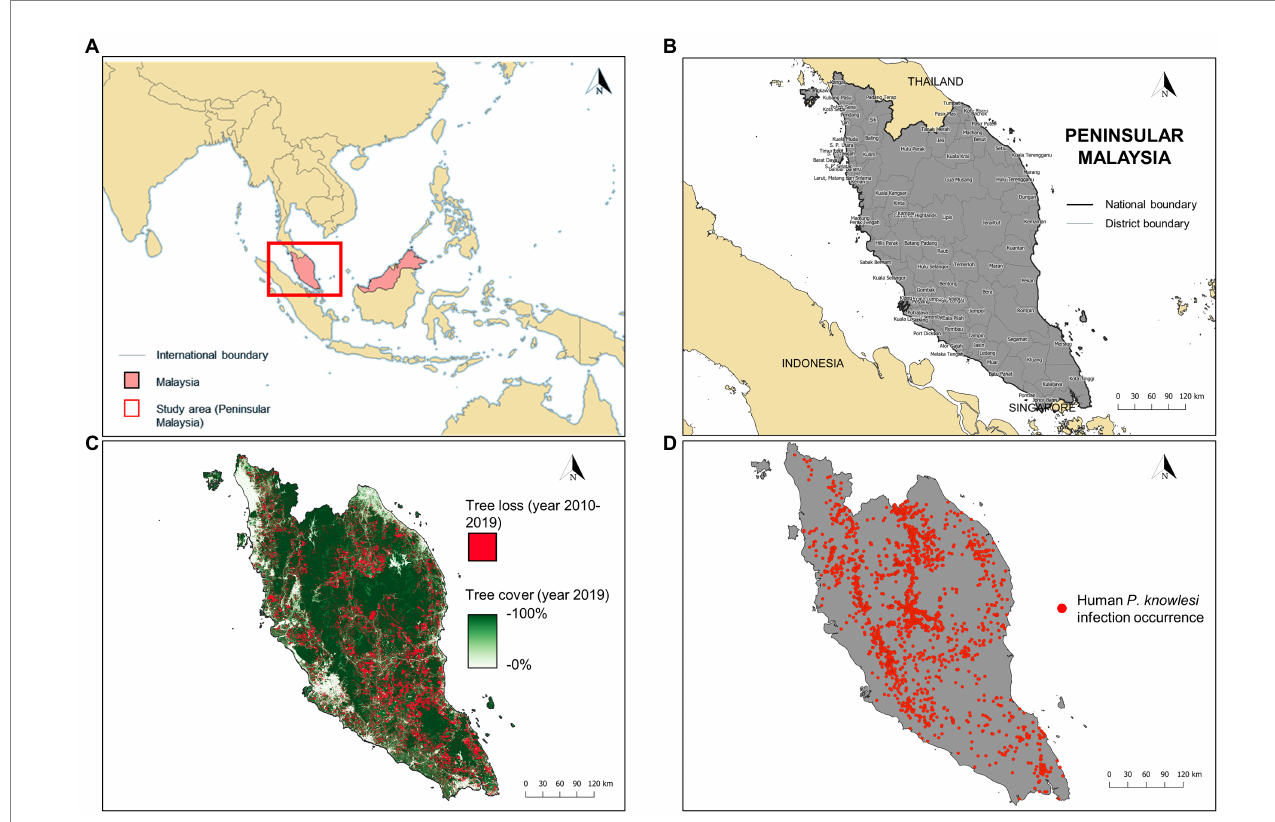
FIGURE 1 (A) Location of Peninsular Malaysia (red box). (B) The district-level administrative boundary of Peninsular Malaysia. (C) Extent of tree loss (recorded in years 2010–2019) and tree cover (recorded in year 2019) in Peninsular Malaysia. Tree loss data was acquired from Global Forest Change database (https:// earthenginepartners.appspot.com/science-2013-global-forest/download_v1.7.html) whereas tree cover data was acquired from Copernicus Global Land Service (https://zenodo.org/record/3939050#.Yw-ZpXZBzIU). (D) Geolocated cases of human knowlesi malaria ( n = 2,873) throughout Peninsular Malaysia from years